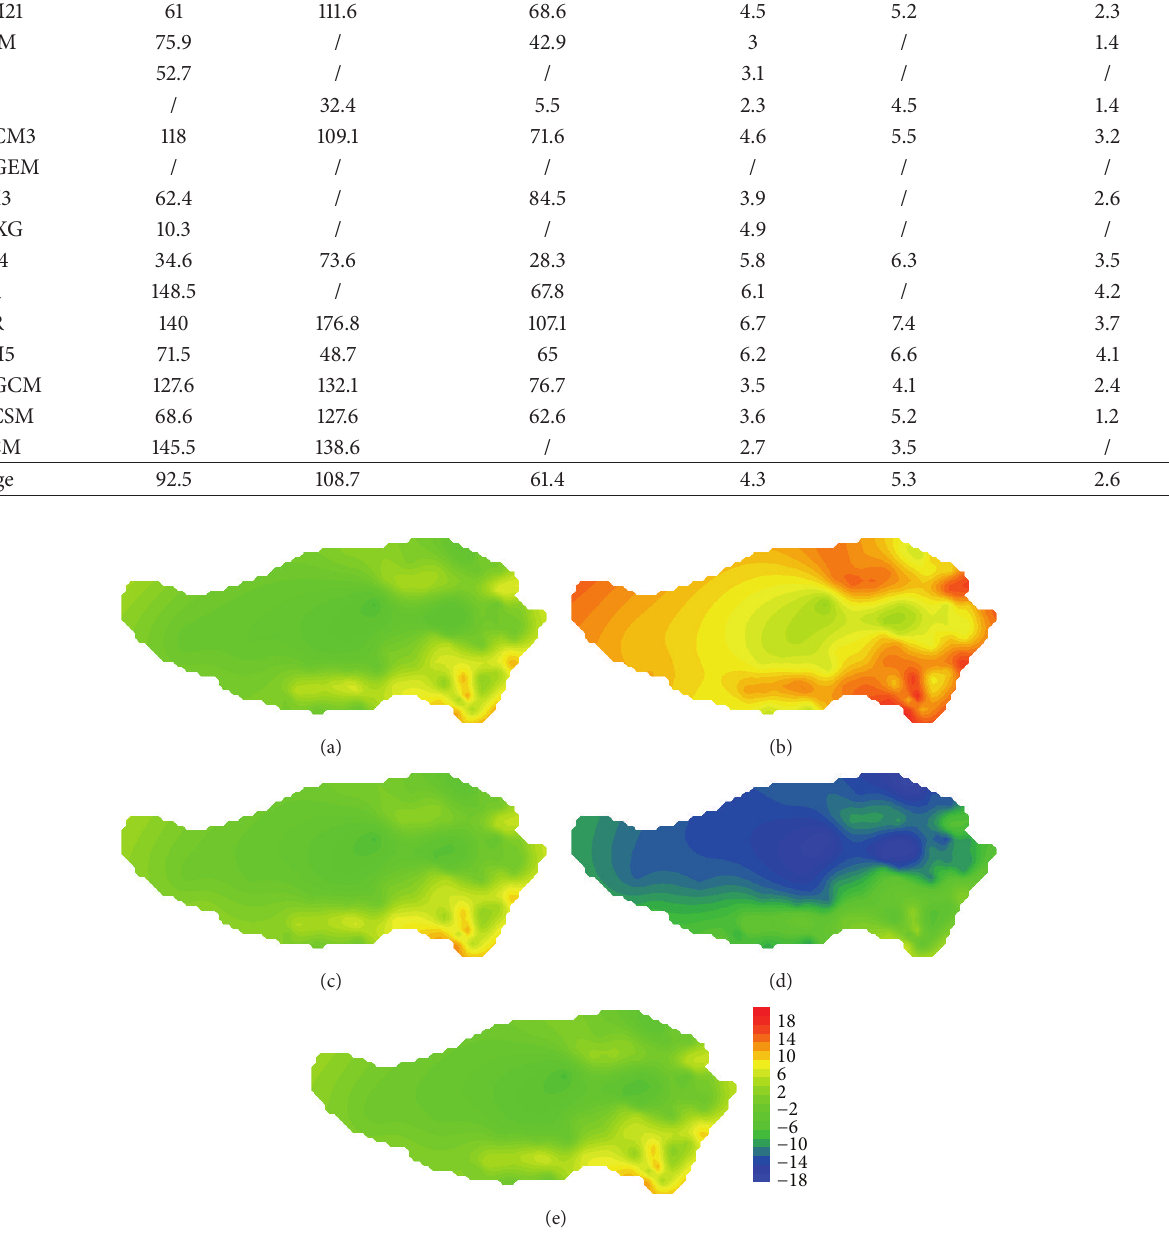
Figure 4: Observed values of temperature on the Tibetan Plateau in reference period: (a) spring; (b) summer; (c) fall; (d) winter; (e)